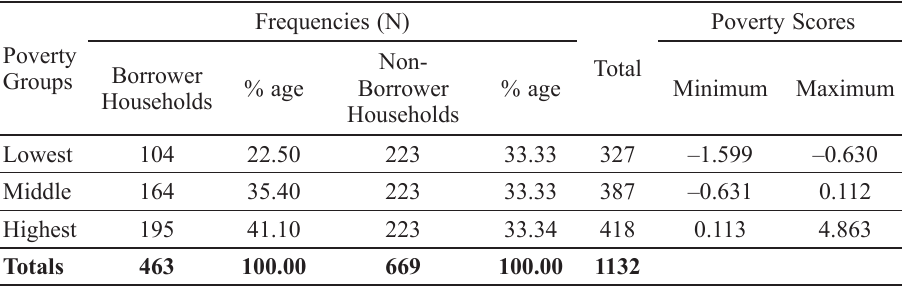
Table 3 . Summary of distribution of the entire dataset across the three poverty levels